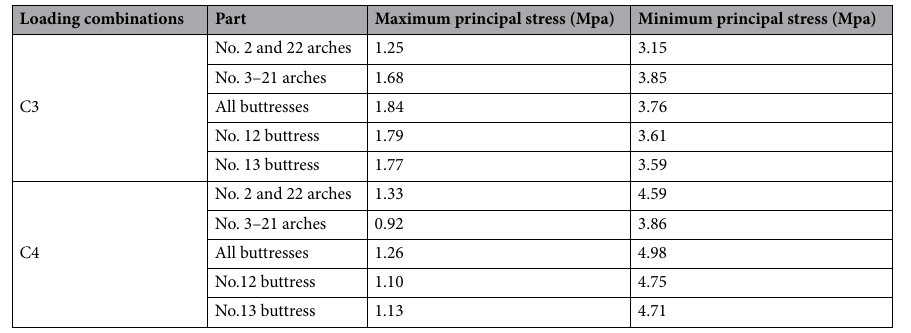
Table 5. Maximum and minimum principal stresses in C3 and